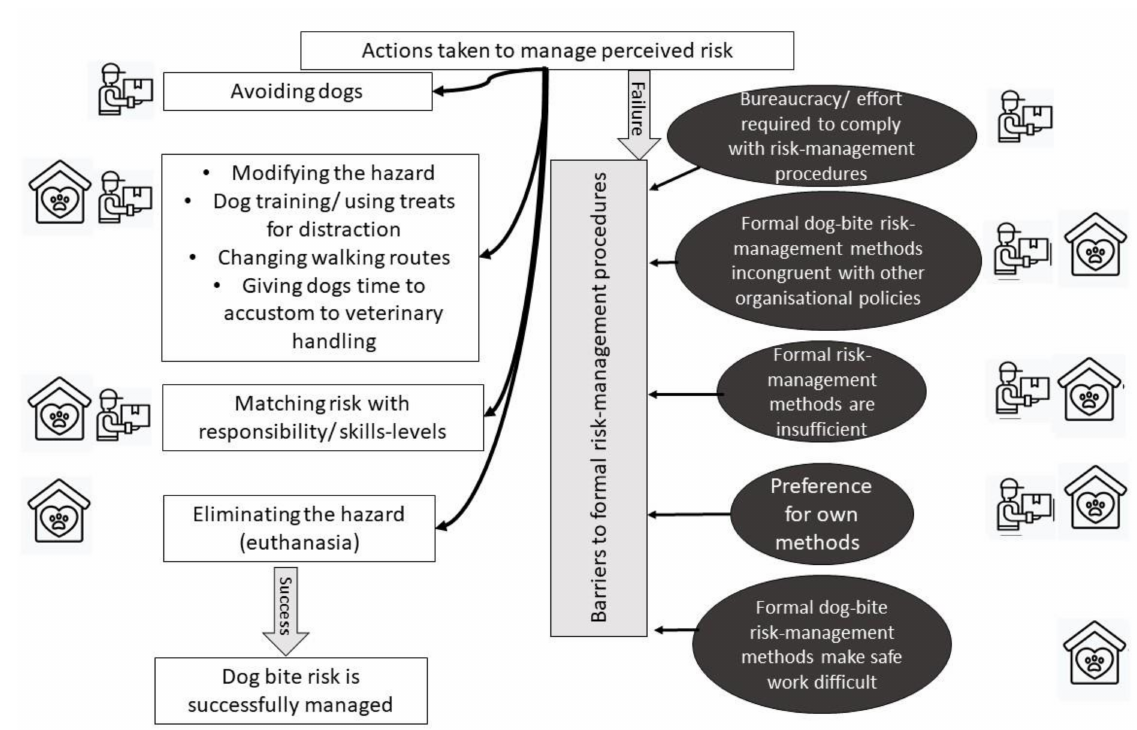
Figure 4. Schematic representation of actions taken to manage perceived risk. Successful implementation of avoidance, hazard modification, matching risk with responsibility/ skills-levels and hazard elimination helps to manage risk. However, a number of barriers to formal risk-management procedures in both dog shelters and delivery companies